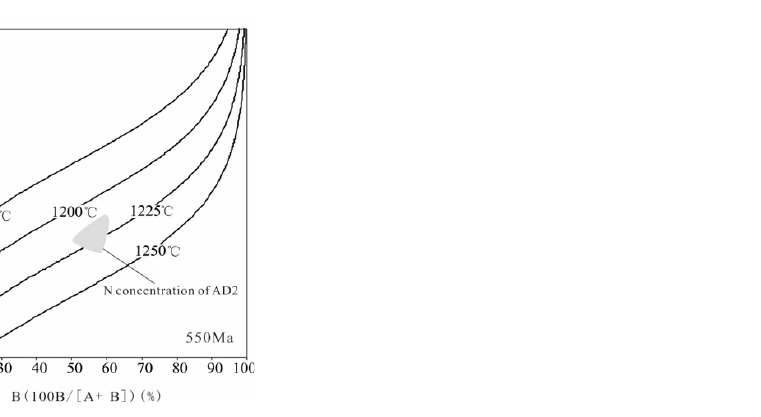
Figure 6. Nitrogen content plotted against the percentage of B (100B/[A+ B]) aggregation in 550 Ma for Type IaAB diamonds [37,59].